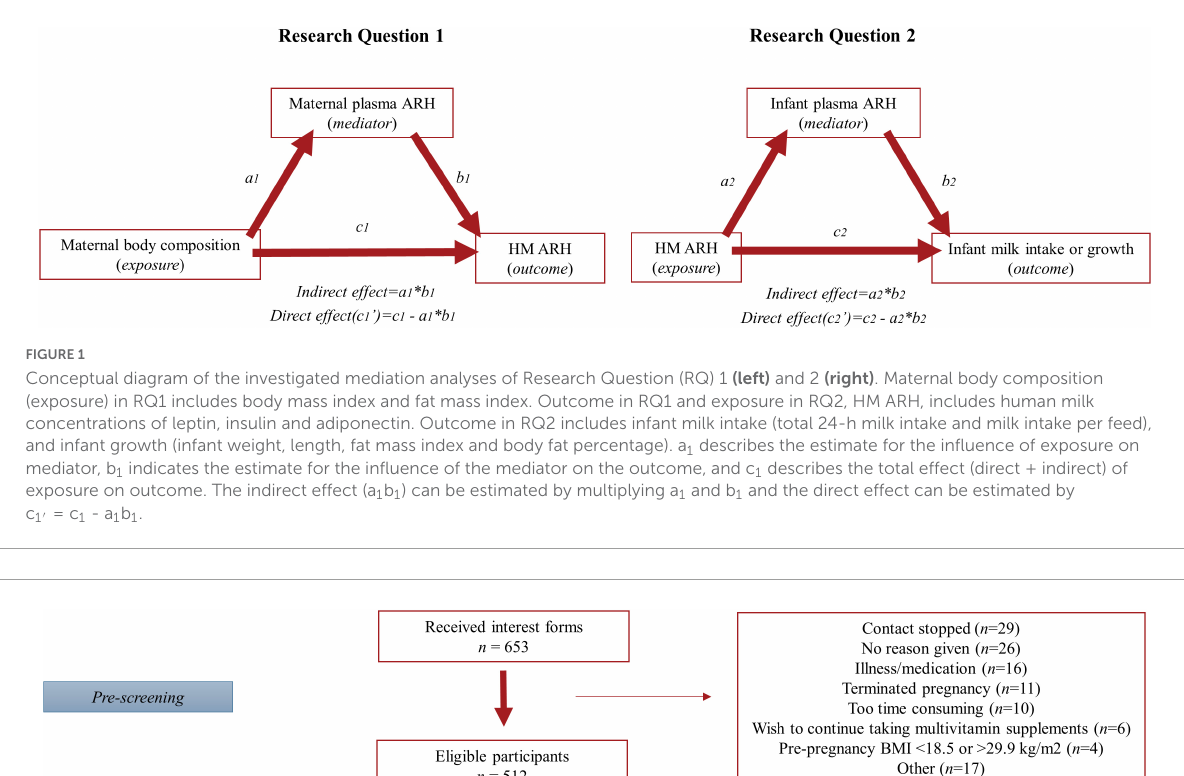
FIGURE2 Flow diagram of participants included in the study.